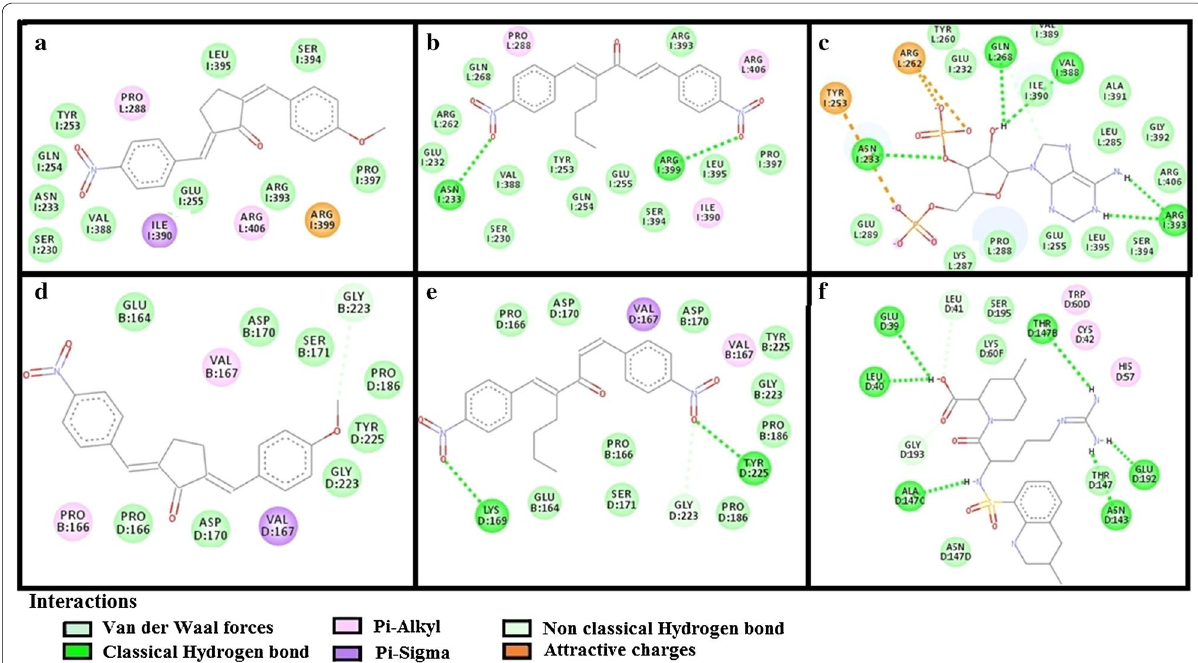
Fig. 10 a – c Represents interactions of ligands: (2 E ,5 E )‑2‑(4‑methoxybenzylidene)‑5‑(4‑nitrobenzylidene)cyclopentanone (AK‑1a), (1 E ,4 E )‑4‑(4‑nit robenzylidene)‑1‑(4‑nitrophenyl) oct‑1‑en‑3‑one (AK‑2a) and heparin sulphate with target: antithrombin‑III (AT‑III) respectively. d – f Represents interactions of AK‑1a, AK‑2a and argatroban with target: factor‑II (F‑II) respectively, drawn through Biovia Discovery Studio Visualizer client 2016